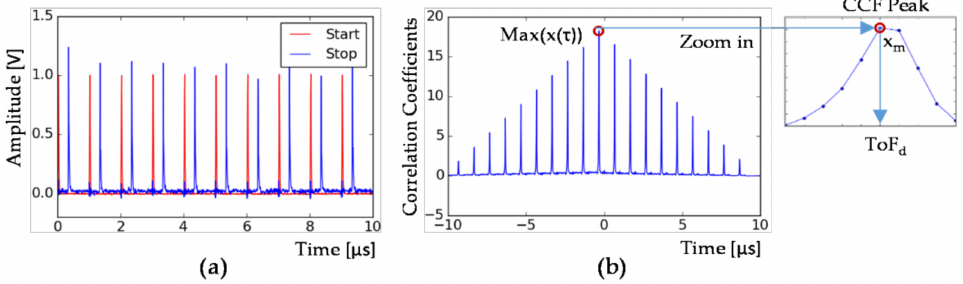
Figure 10. Estimating delay time by cross-correlation method: ( a ) a 10 µ s start and stop signal segment; ( b ) correlation coefficients and peak position obtained.